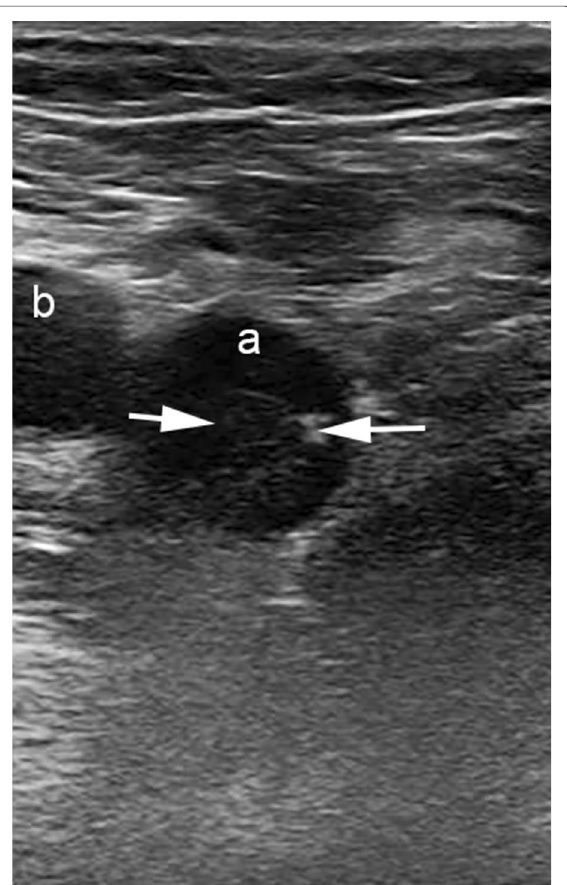
Fig. 2 Ultrasound image of a person with compression ultrasound confirmed DVT. Short axis ultrasonographic view of the right femoral vein ( a ) showing thrombus (arrows) attached to the wall. The right superficial femoral artery ( b ) is seen adjacent to the femoral vein. DVT: deep vein